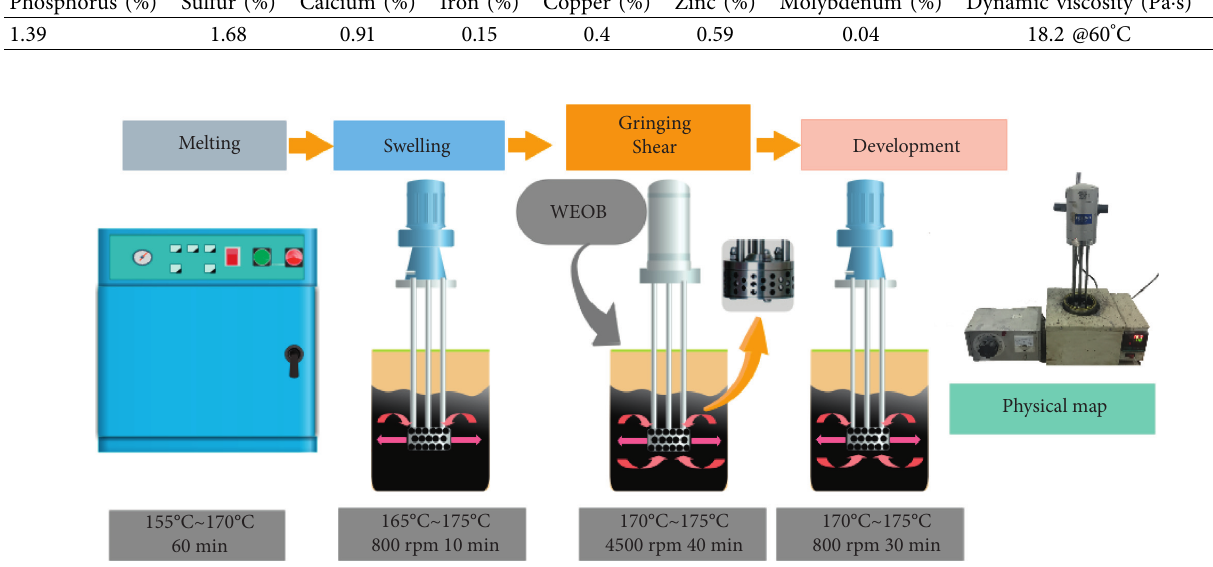
Figure 3: Preparation process of WEOB/SBS-modified binder. Table 3: WEOB or WEO content in existing studies and